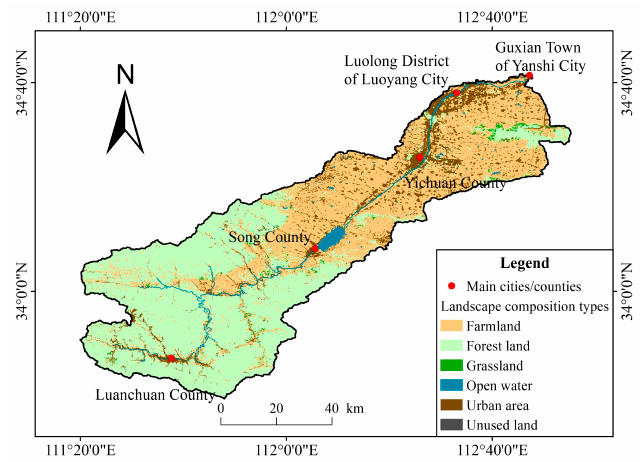
Figure 2. Main landscape composition types in the Yi River watershed.